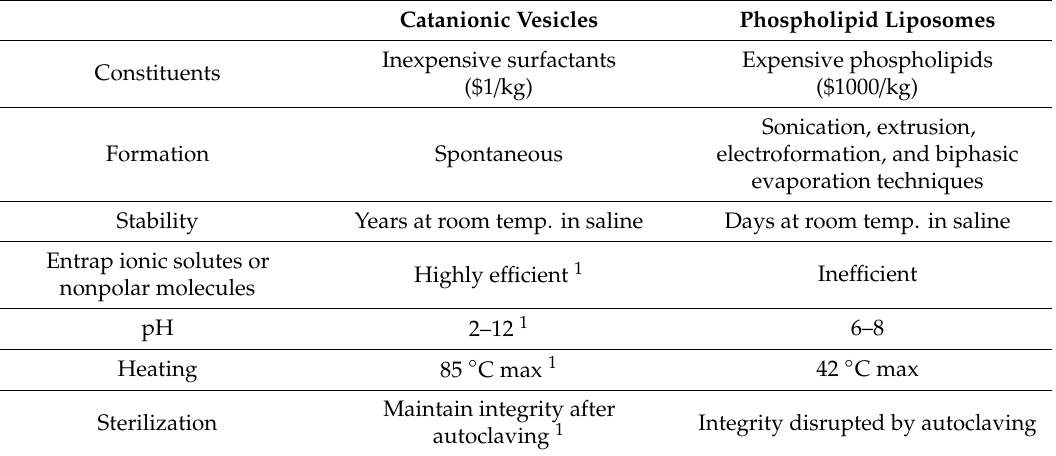
Table 2. Comparison of physicochemical features of Surfactant Vesicles (SVs) to